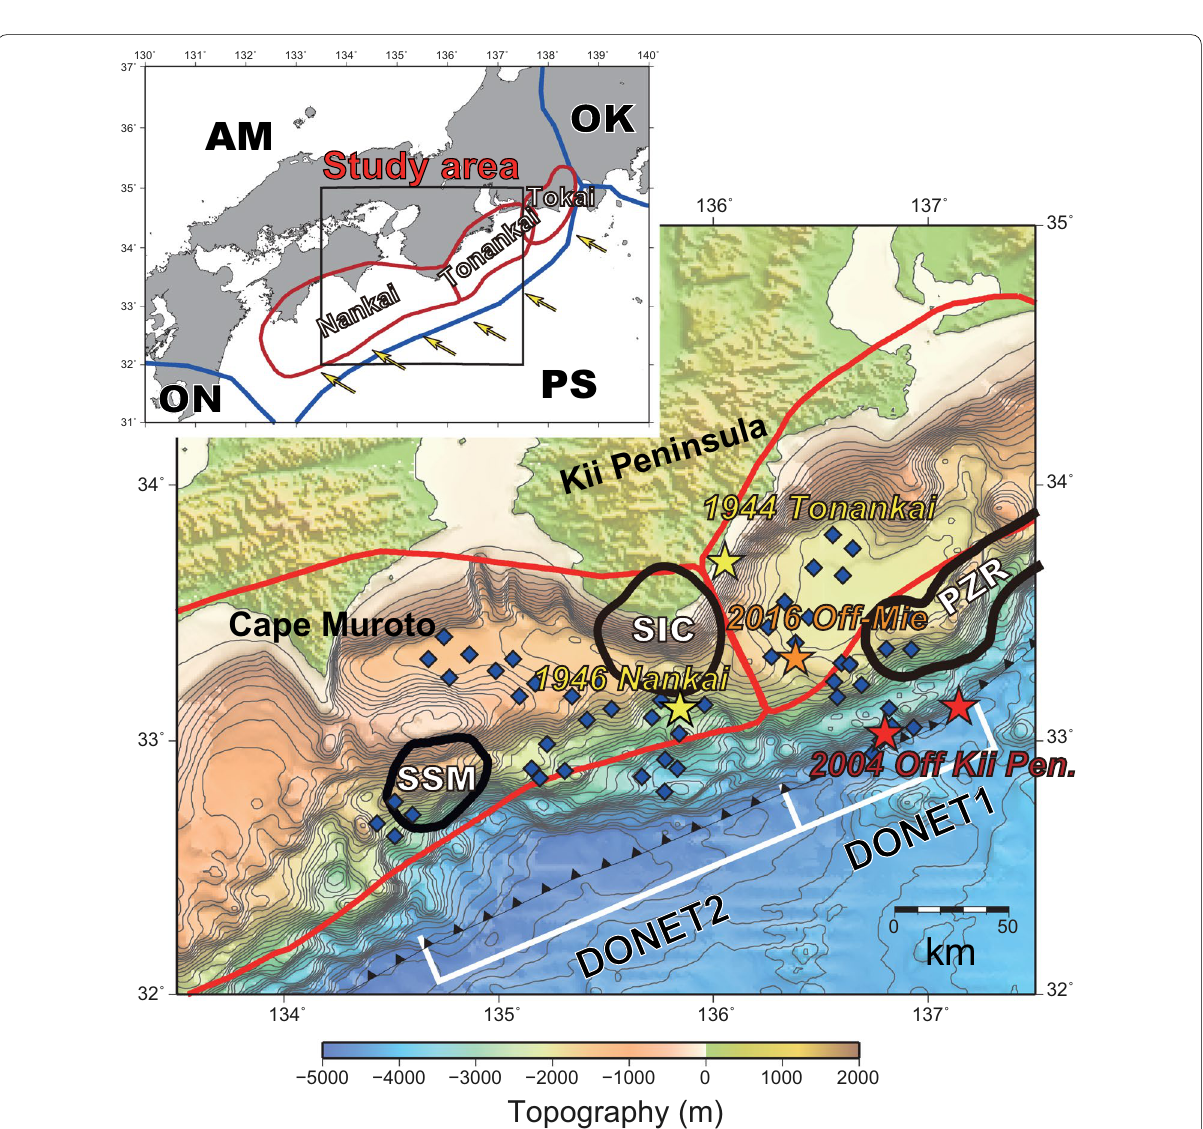
Fig. 1 Maps of the study area. The inset regional map shows the location of the study area with the megathrust seismogenic segments (Tokai, Tonankai, and Nankai) of the Nankai Trough in southwestern Japan with plate boundaries. Two letter abbreviations reflect the name of the Plate; AM: Amur Plate, PS: Philippine Sea Plate, OK: Okhotsk Plate, and ON: Okinawa Plate (Bird 2003). Yellow allows are the relative motion of the PS with AM (Argus et al. 2011). In the main topographic map, the megathrust seismogenic zones along the Nankai subduction zone are shown by the red line. The Shionomisaki igneous complex (SIC; Kodaira et al. 2006), subducted seamount identified off Cape Muroto (SSM; Yamamoto et al. 2017), and subducted Paleo-Zenith Ridge (PZR; Park et al. 2004) are outlined in black. Blue diamonds show the location of the seismic stations of the Dense Oceanfloor Network system for Earthquakes and Tsunamis (DONET). The epicenters of the 1944 Tonankai and 1946 Nankai earthquakes were taken from Kanamori (1972) (yellow stars), and two M > 7 earthquakes of the Kii Peninsula occurring on September 5, 2004 (red stars) and the M JMA 6.5 off-Mie earthquake occurring on April 1, 2016 (orange star) are from the JMA unified